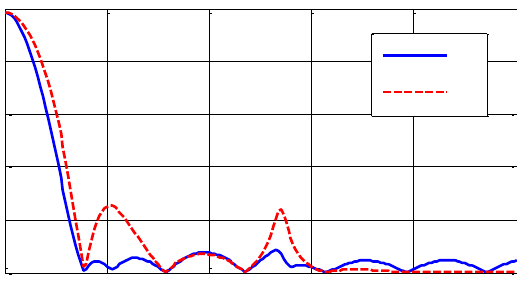
Figure 8: Spectrums of signals V P 1 and V P 2